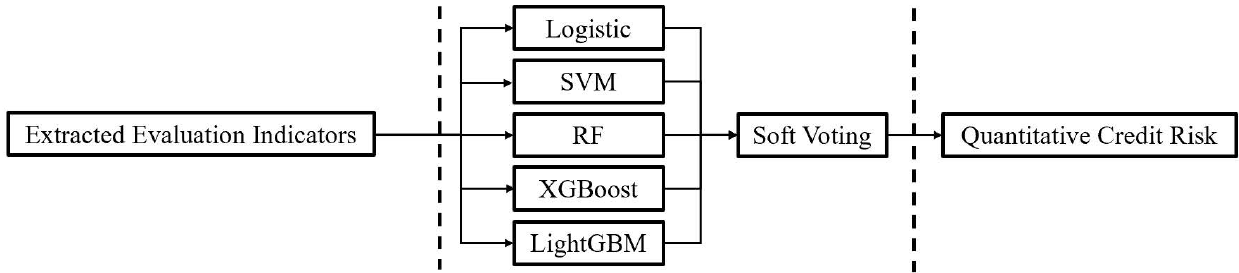
Figure 1. Integration framework of soft